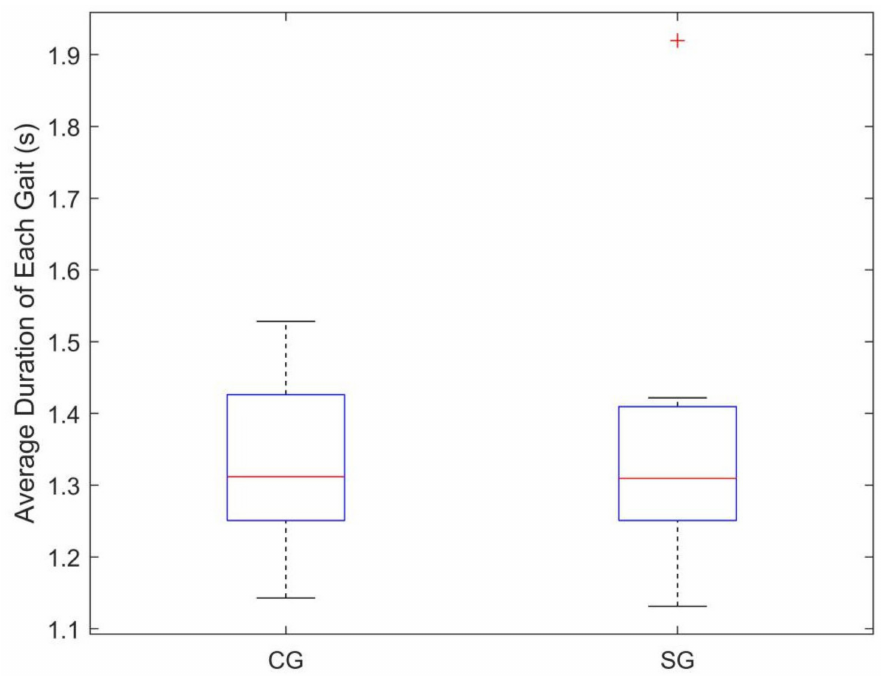
Figure 3. Average duration of each Gait for subjects in different groups. The ‘+’ in the figure represents the